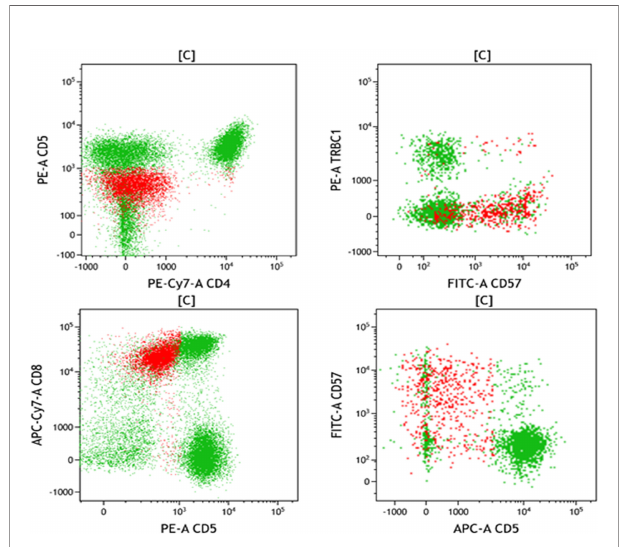
FIGURE 3 | The fl ow phenotype of the blood cells presented as two- dimensional